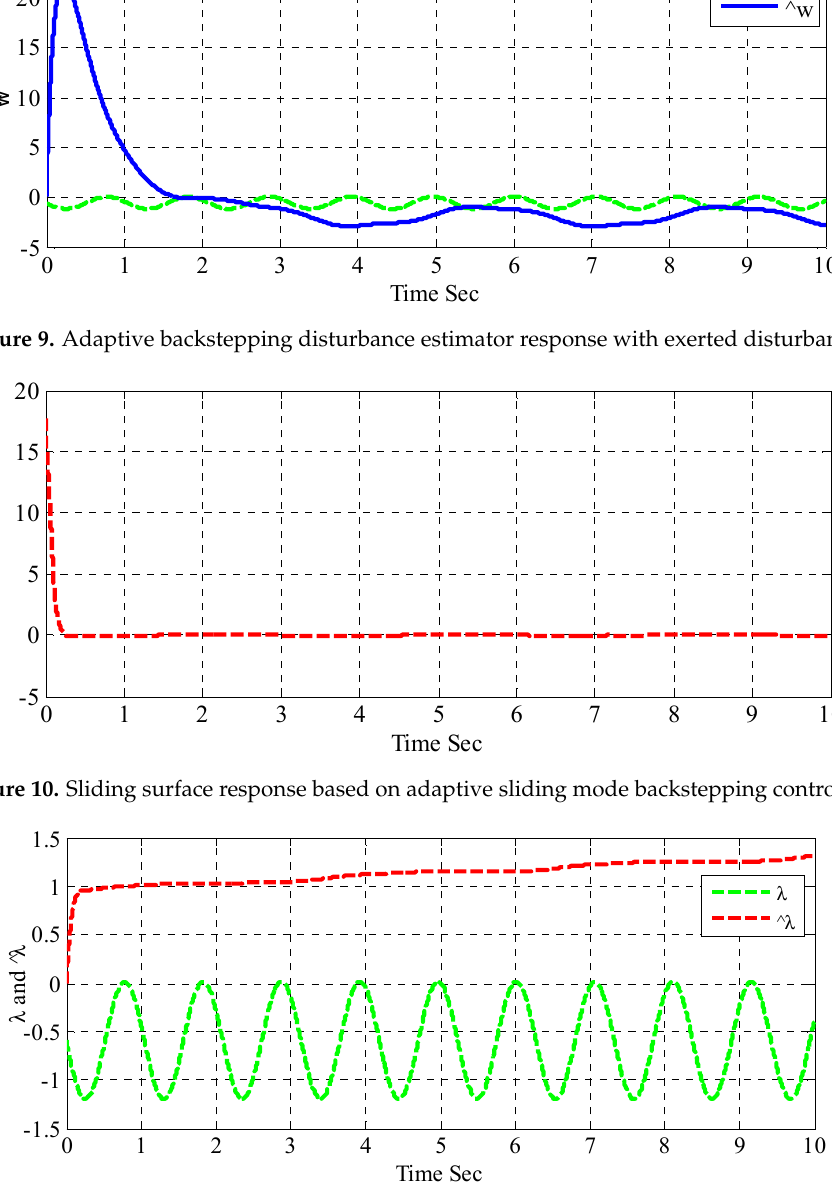
Figure 11. Disturbance upper bound estimation response with exerted disturbance based on adaptive sliding mode backstepping controller